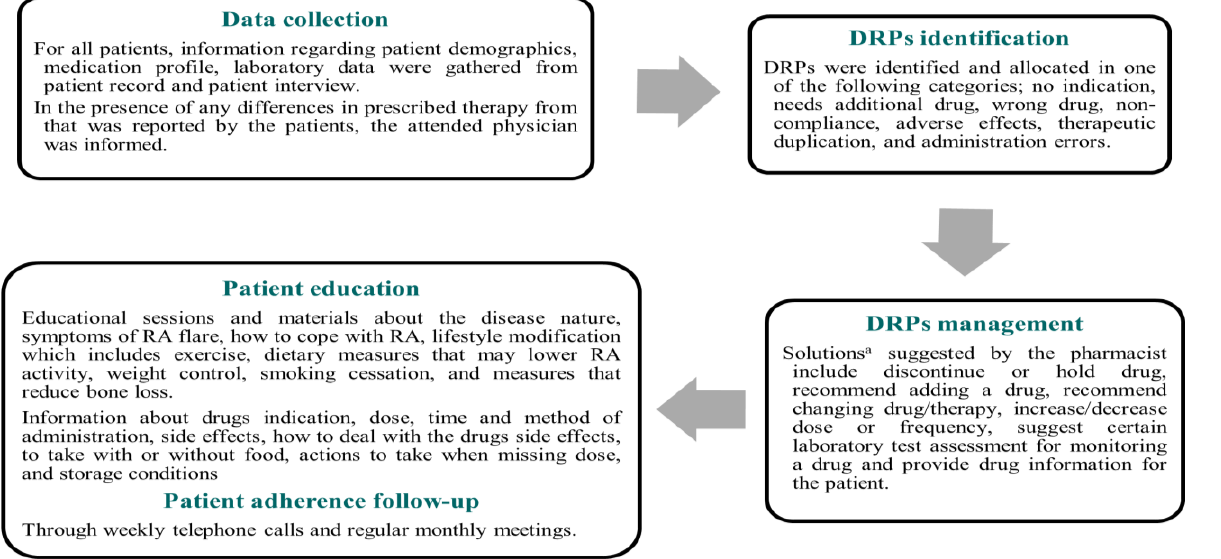
Fig. 2. Pharmaceutical care services chart showing detailed steps performed by the pharmacist. a All these solutions were based on suitable guidelines and discussed with the attending rheumatologist [28] . DRPs: drug-related